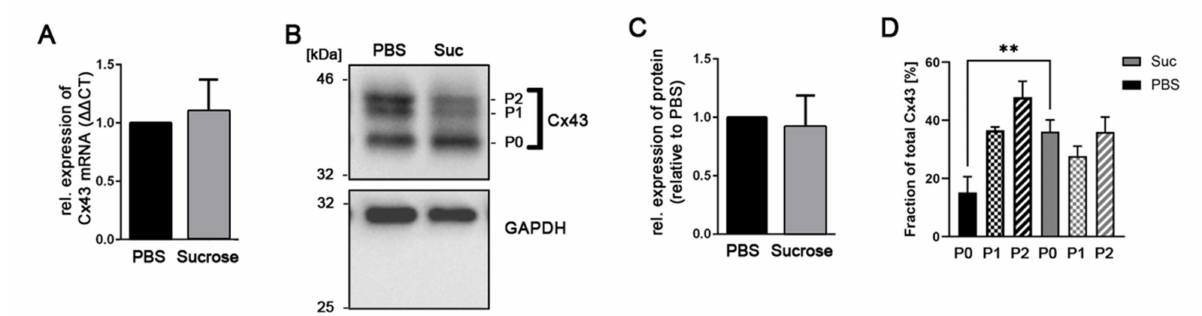
Figure 2. Sucrose does not affect Cx43 mRNA or protein expression. Astrocytes were treated with sucrose ( n = 3) or with PBS as control ( n = 3) for five minutes. ( A ) qPCR was performed with specific primers for Cx43 and results were normalized to 18S rRNA expression. Calculating the relative expression changes with respect to PBS-treated cells (=1) according to Pfaffl et al. revealed no changes. ( B ) SDS-PAGE of cell extracts and immunoblotting with an antibody recognizing all phosphorylation forms of Cx43 with GAPDH as a loading control were performed. Cx43 immunosignal showed unphosphorylated (P0) isoforms as well as two phosphorylated (P1/P2) isoforms. Original images are shown in Supplementary File S1. ( C ) Quantification of signal intensities, performed on the overall immunosignal per sample, did not show any significant changes of total Cx43 protein content. Shown are means + SEM of signal intensities relative to the control. ( D ) Differential quantification of immunopositive bands P0, P1, and P2 of PBS- (black columns) and sucrose- (gray columns) treated samples. Individual comparisons of P0, P1, and P2 band intensities between groups revealed significant differences for P0 bands (** indicates p < 0.0051; uncorrected Fisher’s